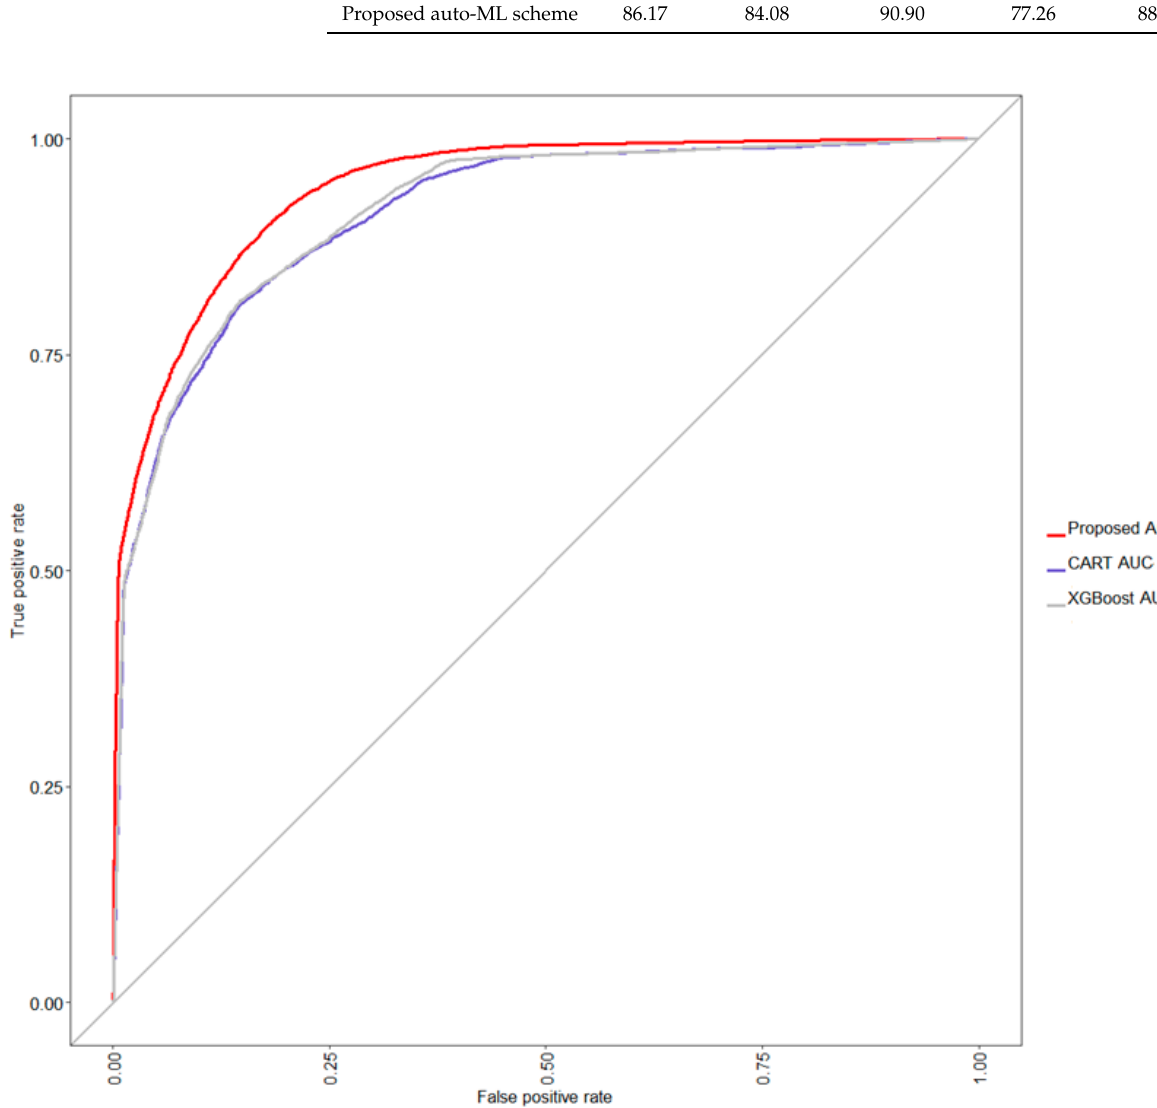
Figure 5. The ROC curve among different methods. Auto-ML, CART, XGBoost, and AUC are the abbreviations of automatic machine learning, classification and regression tree, eXtreme gradient boosting extreme, and area under curve respectively.